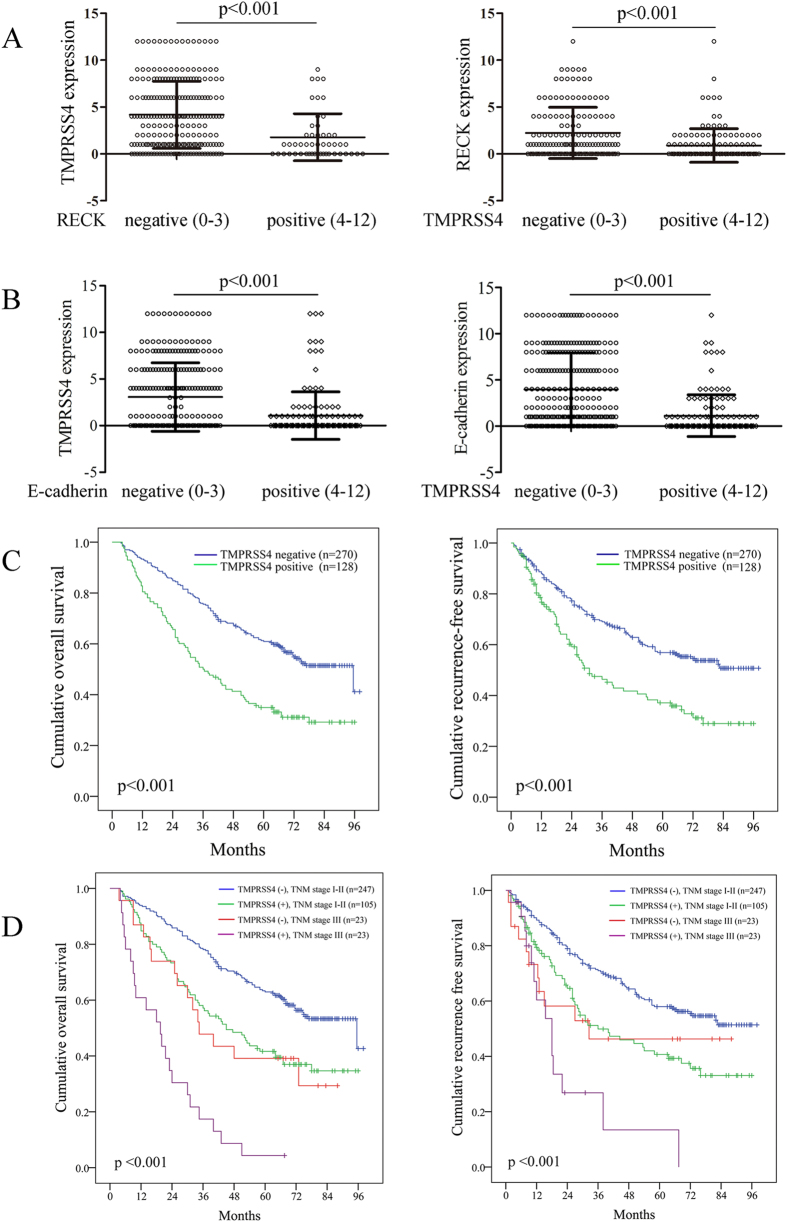
A Statistical analysis of TMPRSS4/RECK expression in HCC sections negative (score, 0–3) and positive (score, 4–12) for RECK/TMPRSS4 staining (p < 0.001); B Statistical analysis of TMPRSS4/E-cadherin expression in HCC sections negative and positive for E-cadherin/TMPRSS4 staining (p < 0.001). The immunoreactive score is shown as mean ± SD; C The prognostic significance assessed by using Kaplan-Meier survival estimates and log-rank tests. Comparisons of OS and DFS by TMPRSS4; D Comparisons of OS and DFS by TMPRSS4 and TNM stage.